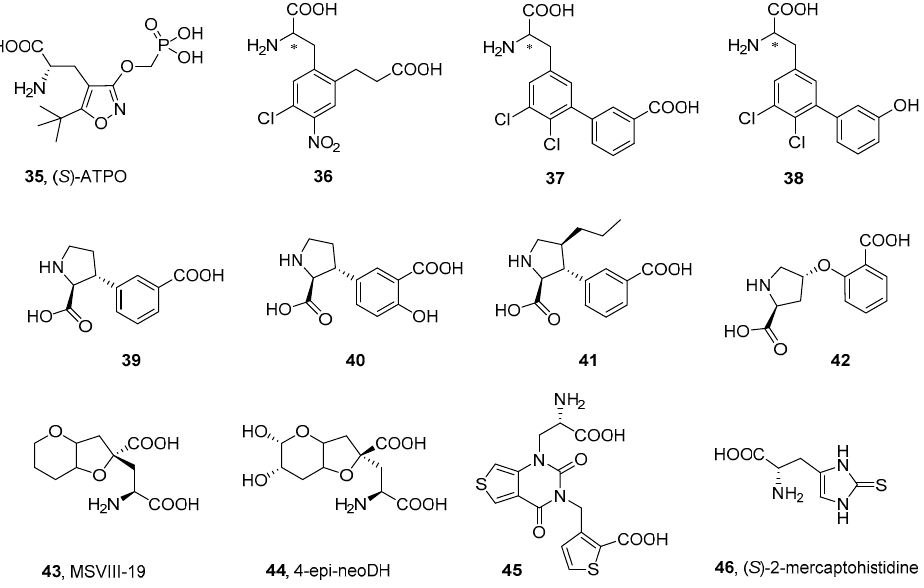
Figure 6. Structures of selected α -amino acid antagonists of kainate receptors. * the stereoisomeric center in the